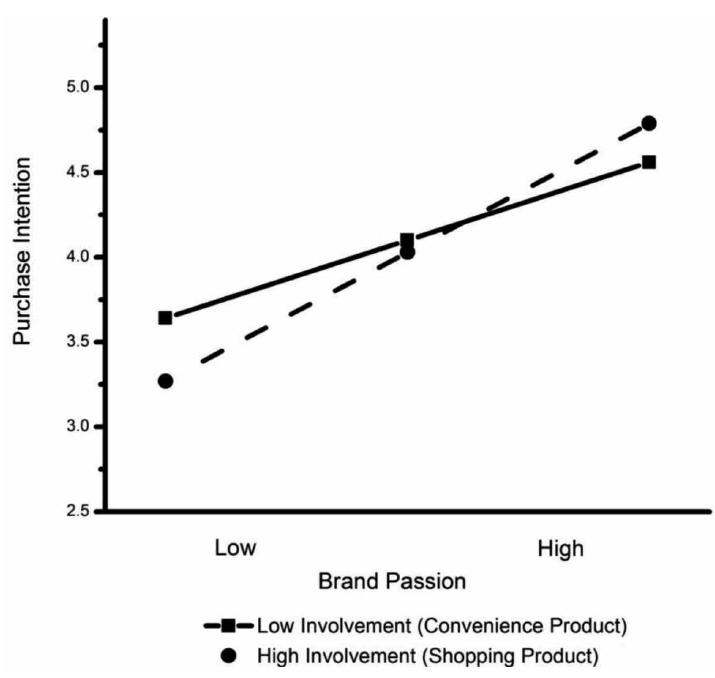
Figure 5. Two-way interaction effects of brand passion by product involvement on purchase